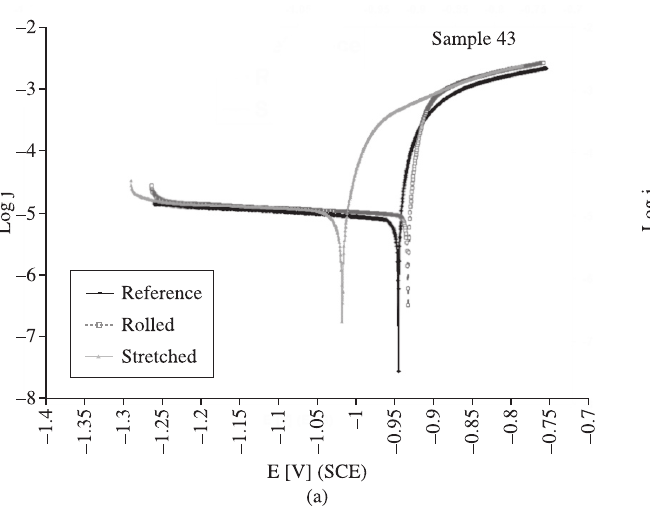
Figure 6. Polarization curves corresponding to two small spangle samples.